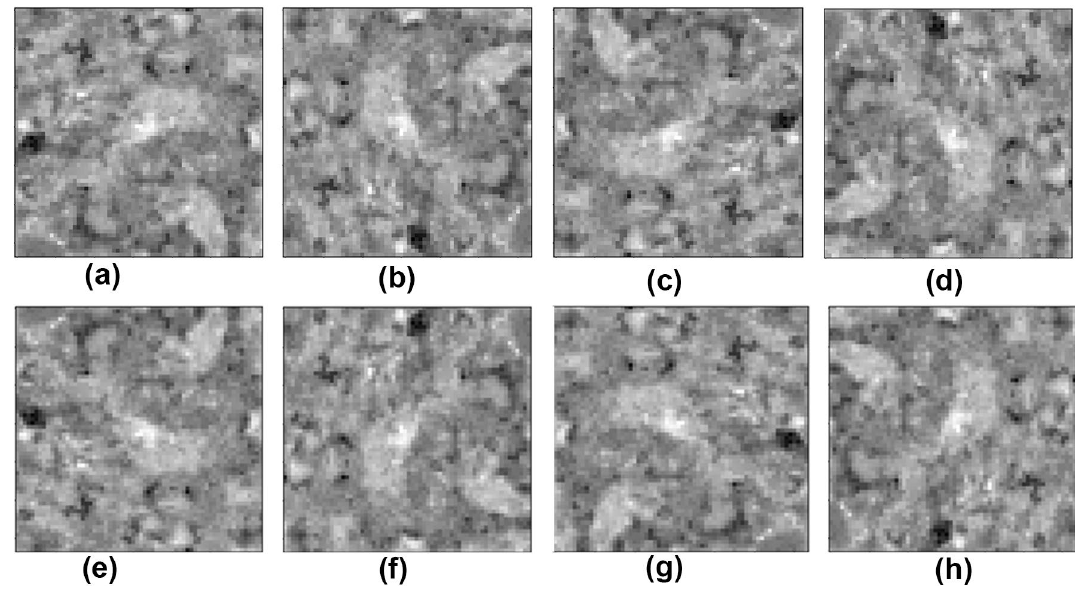
Fig. 4 An example of image augmentation applied on the CT images. a Original CT image, b original image rotated by 90 degrees, ( c ) original image rotated by 180 degrees, d original image rotated by 270 degrees, e original image horizontally flipped, f